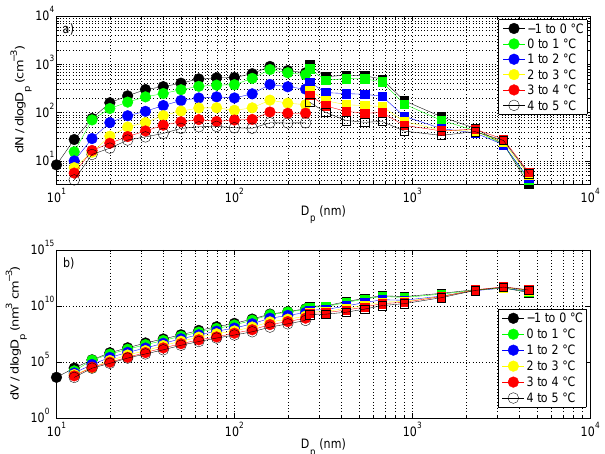
Fig. 11. (a) Median particle number size distributions for different water temperatures. (b) Particle volume size distributions for dif- ferent water temperatures. The cooling experiment was conducted with water which was sampled outside the fjord 3 March 2010 and then stored in a dark room with an air temperature of 4 ◦ C. The part of the size distribution measured by DMPS is marked with circles, whereas the part measured by OPC is marked with squares. Only every second bin data point is shown for